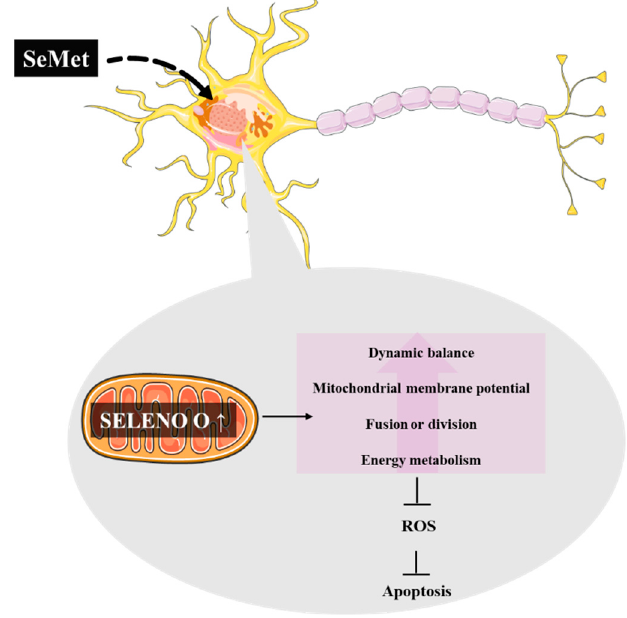
Figure 4. SeMet can improve the mitochondrial function in a model of AD through the upregulation of SELENO O, which is present in the mitochondria [290].